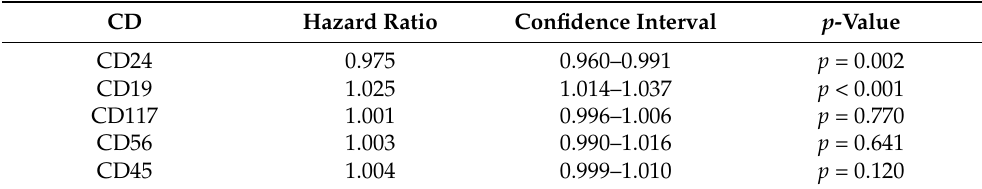
Table 4. Correlations between the progression-free survival hazard ratio and CD expression levels as continuous variables. Hazard Ratio Confidence